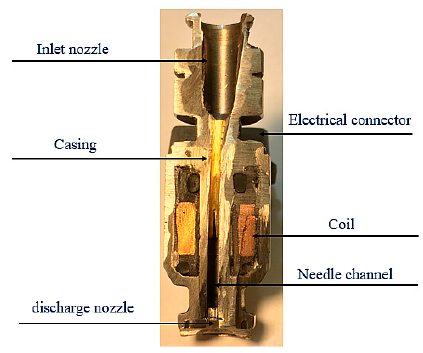
Figure 1. Cross-section of an electromagnetic fuel injector.